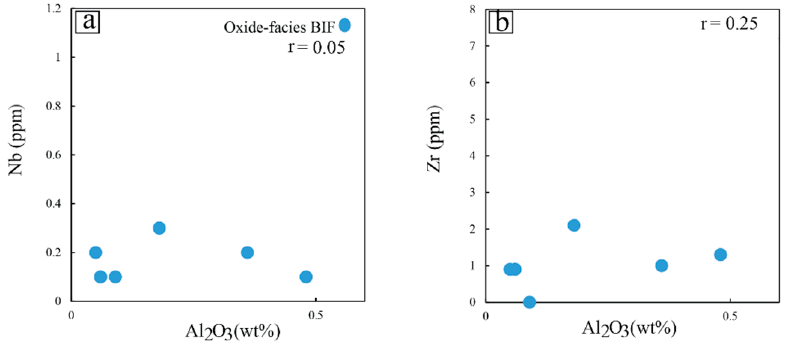
Figure 8. Bivariate diagrams showing Al 2 O 3 vs. Nb and Al 2 O 3 vs. Zr.